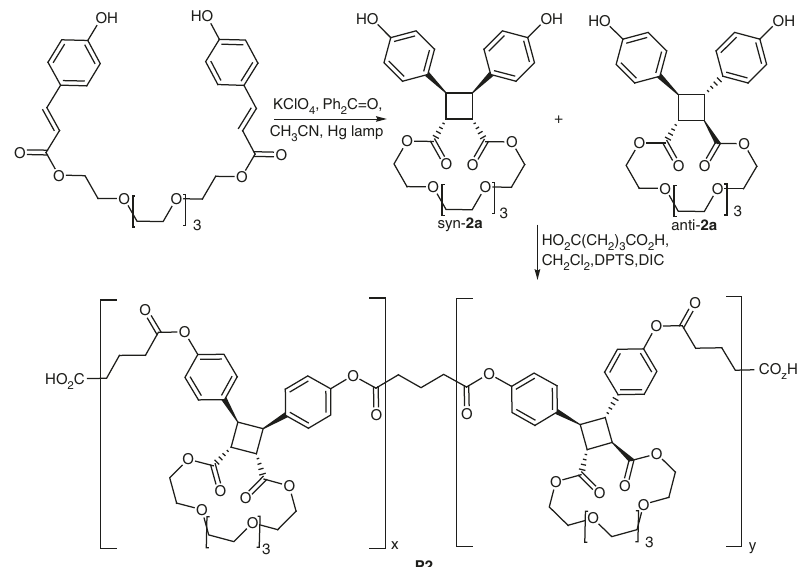
Fig. 3 Synthesis of macrocyclic dimers 2a and their copolymer P2 . DPTS: dimethylaminopyridinium toluenesulfonate, DIC: N , N